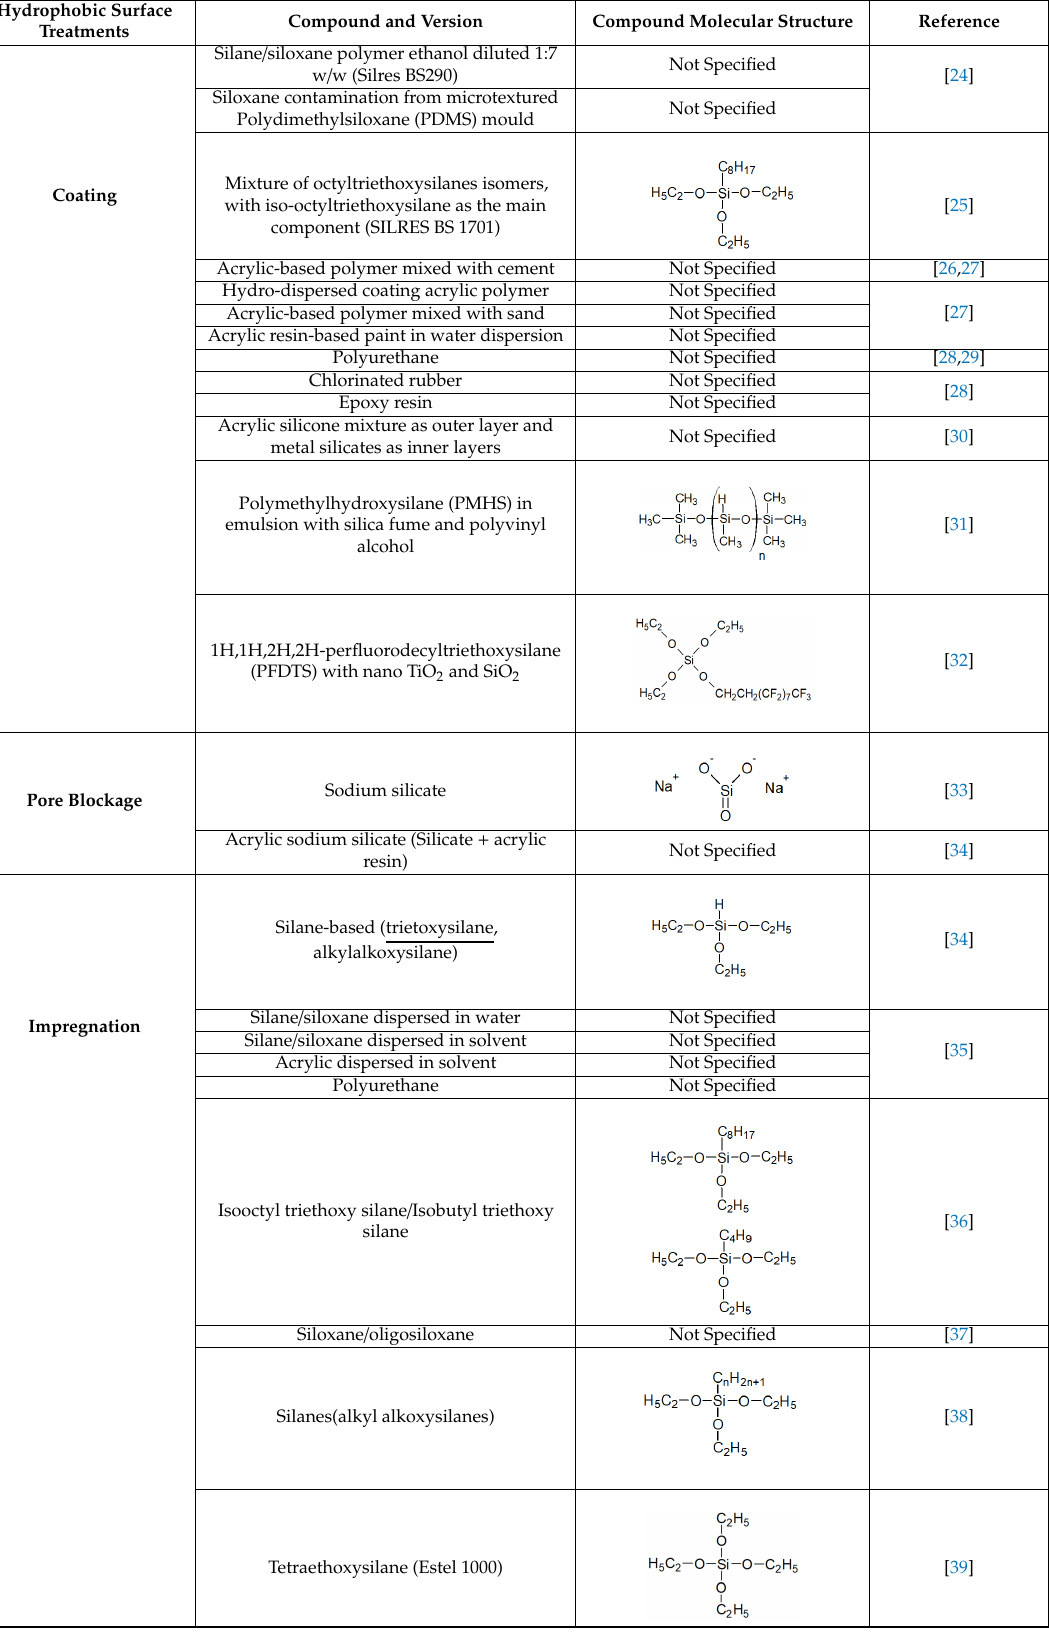
Figure 3. Typologies of hydrophobic surface treatments on concrete: ( a ) coating; ( b ) pore blockage; and ( c ) impregnation. Table 1. Summary of main compounds employed in hydrophobic surface treatments. Table 1. Summary of main compounds employed in hydrophobic surface treatments. Hydrophobic Surface Treatments